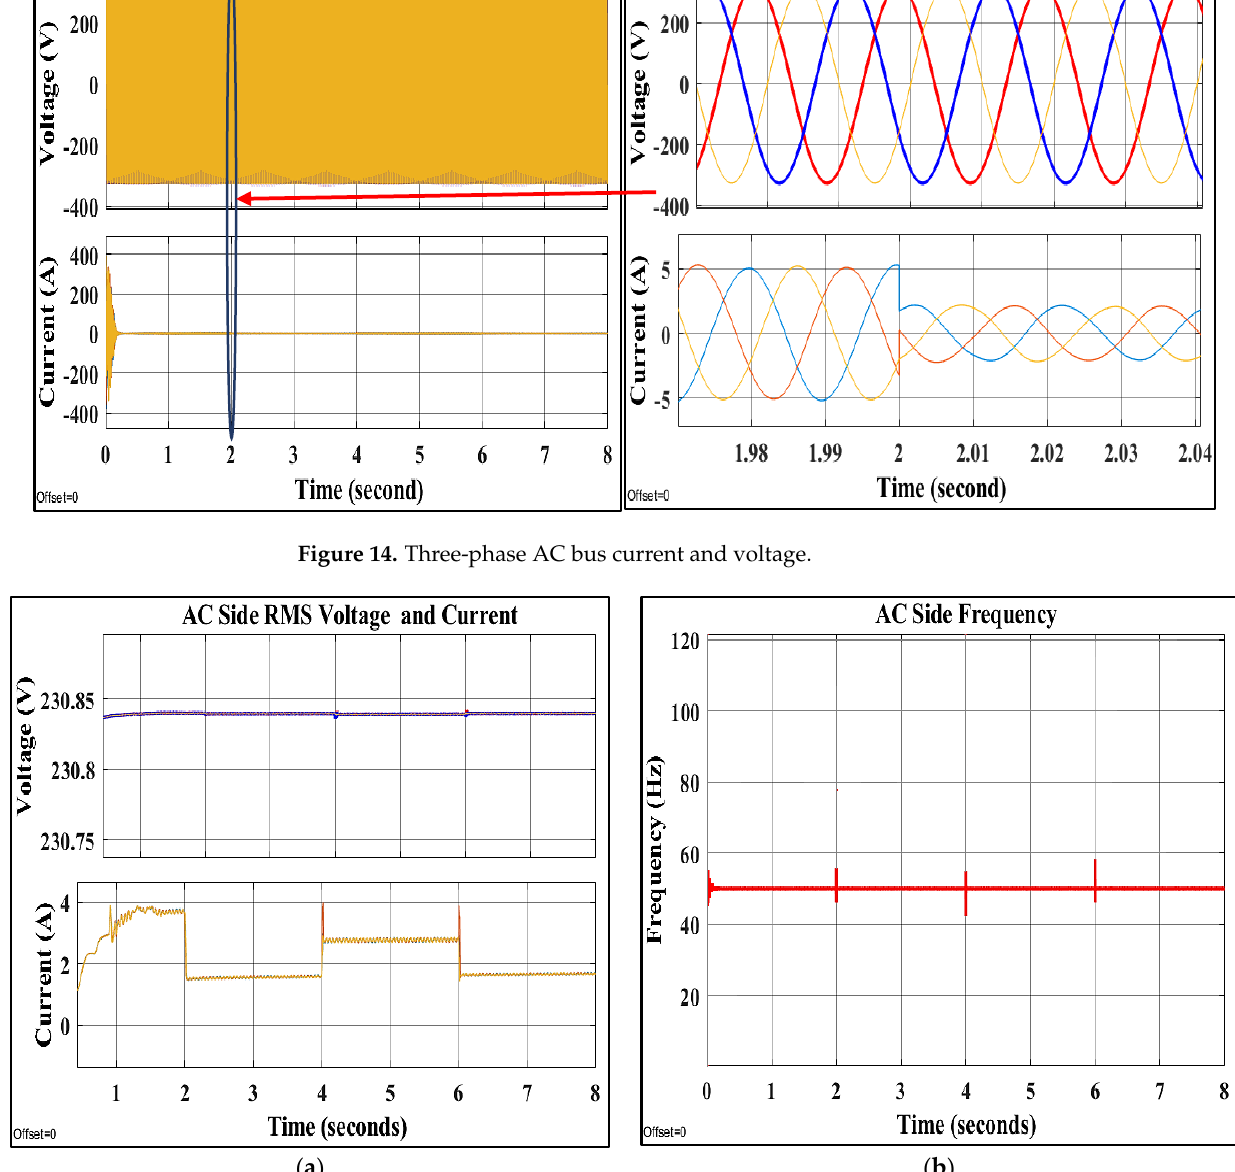
Figure 15. AC bus RMS current and voltage in ( a ) and frequency in ( b ) .